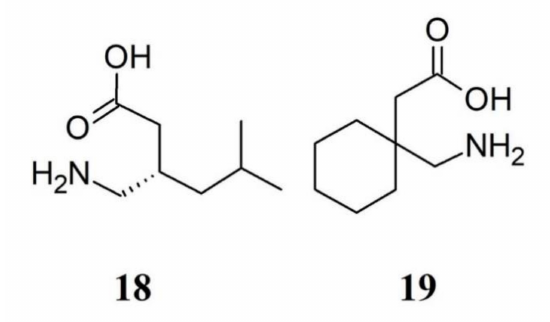
Figure5. Structure formulae of some gabapentinoids. Numbers correspond to molecules cited in the